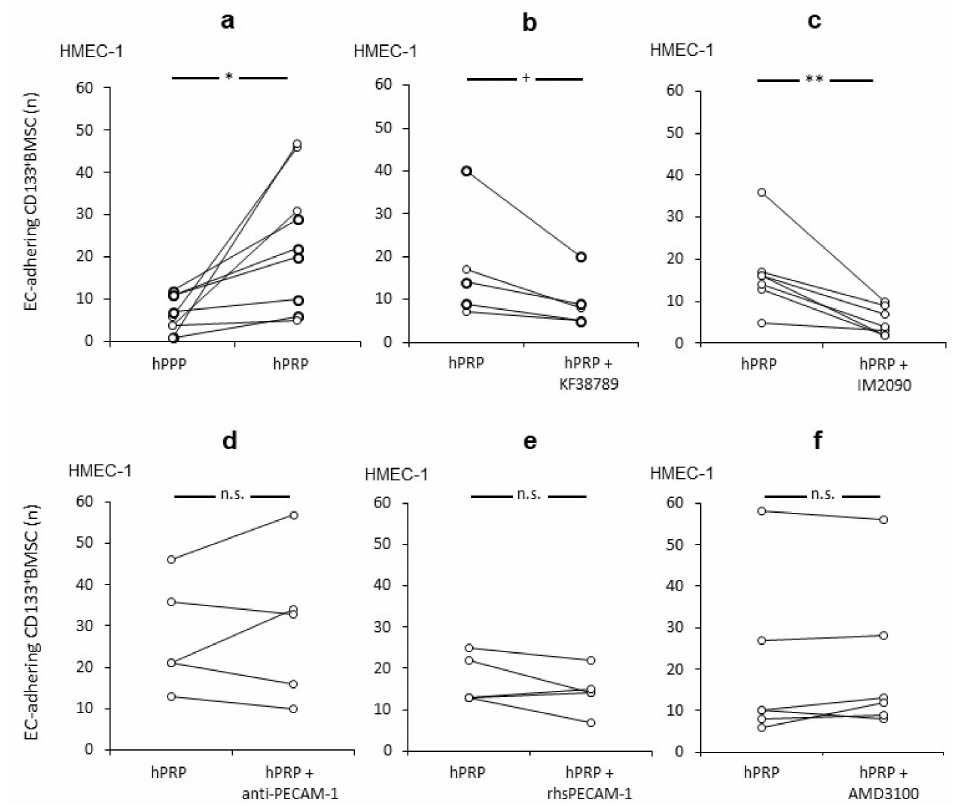
Figure 1. P-selectin / PSGL-1 dependent platelet interactions with CD133 + BMSC promote adhesion to human micro-EC under shear stress. Adherence of CD133 + BMSC to human micro endothelial cells (HMEC-1) co-incubated with human platelet rich plasma (hPRP) was tested by pairs under di ff erent conditions: control and treatment at a time. ( a ) Increased CD133 + BMSC adherence with hPRP when compared to platelet poor plasma (hPPP). ( b , c ) Both Pre-incubation of platelets with P-selectin-inhibitor KF38789 and CD133 + BMSC with PSGL-1 antagonist IM2090 revealed a reduction of adherence of CD133 + BMSC. ( d – f ): Co-incubation with PECAM-1-blocking antibody mPECAM-1.3 IgG (anti-PECAM-1), recombinant soluble human PECAM-1 (rhsPECAM-1) and CXCR4-inhibitor for SDF-1 interaction AMD3100 respectively lacked a modulating e ff ect on CD133 + BMSC for adherence to HMEC-1. Paired t -test: * p < 0.05; ** p < 0.01; + p = 0.067; n.s. p >